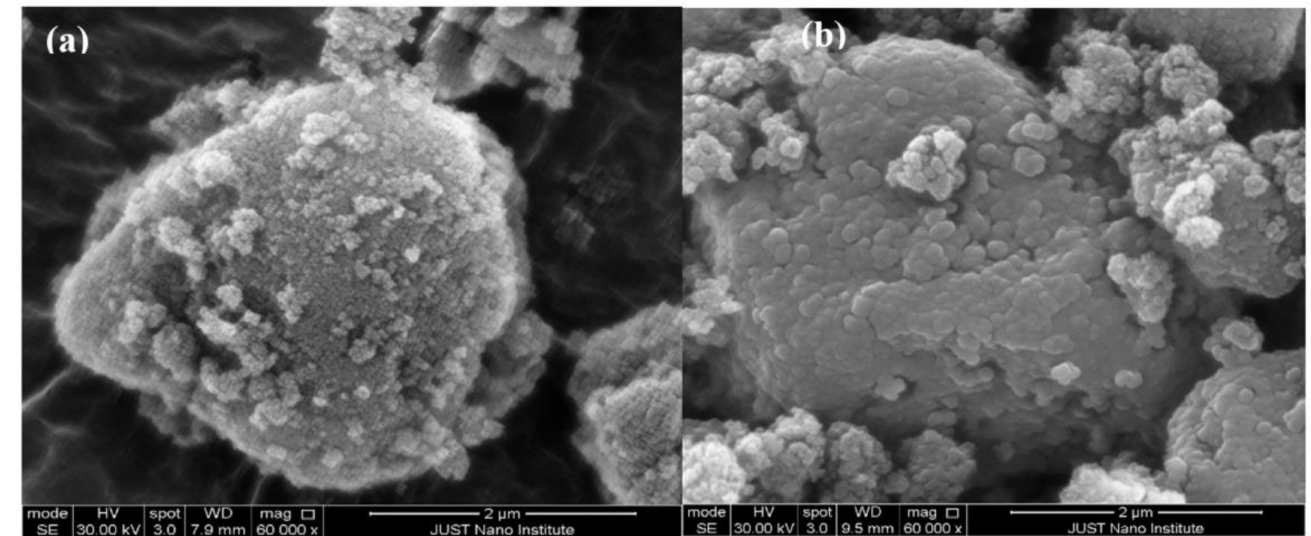
Figure 6. SEM images of ( a ) Pure SYL and ( b ) PGZ loaded S-SNEDDS. Abbreviations: SEM, scanning electron microscopy; SYL, Syloid; S-SNEDDS, solidified self-nanoemulsifying drug delivery system; PGZ, Pioglitazone